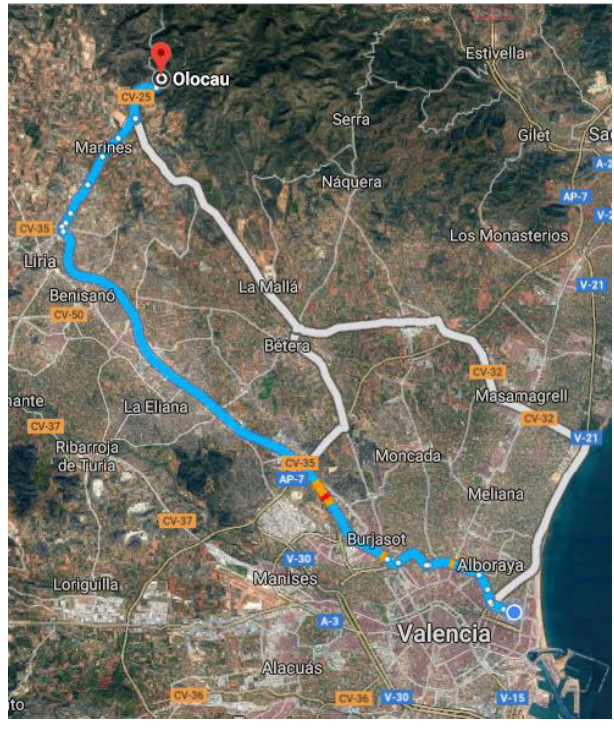
Figure 2. Simulated route.